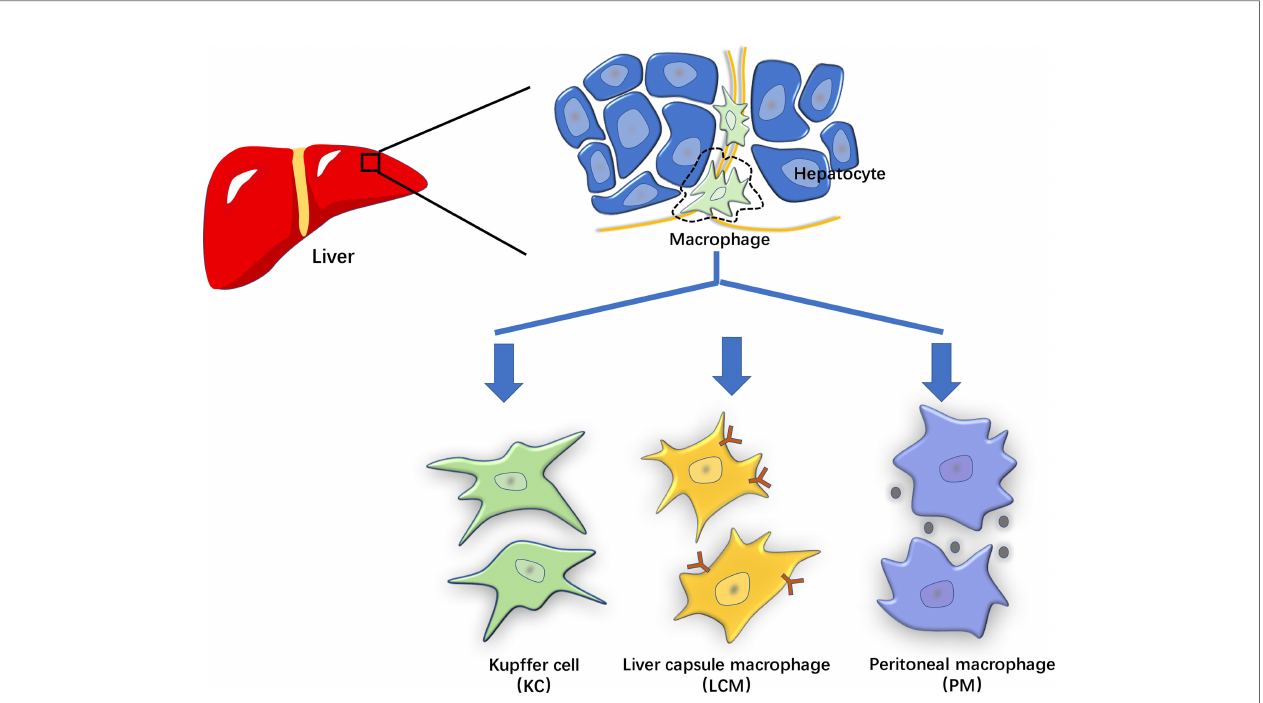
FIGURE 2 | The characterization of hepatic macrophages. The hepatic macrophages based on their origin and molecular features can be classi fi ed into liver-resident cells such as Kupffer cells (KCs) and liver capsular macrophages (LCMs), and non-resident cells such as monocyte-derived and peritoneal macrophages